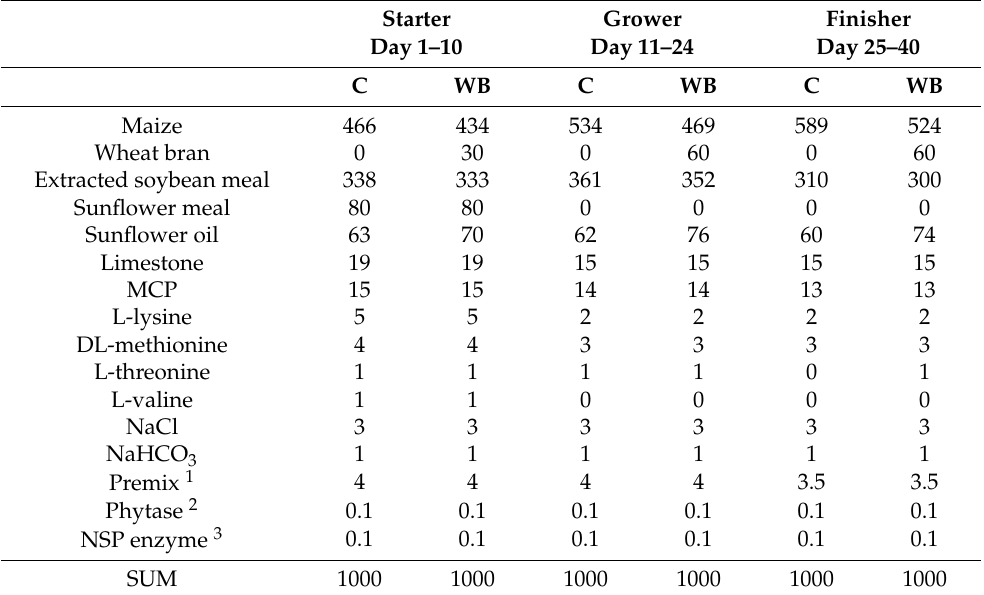
Table 1. Composition of experimental diets (g/kg as fed).